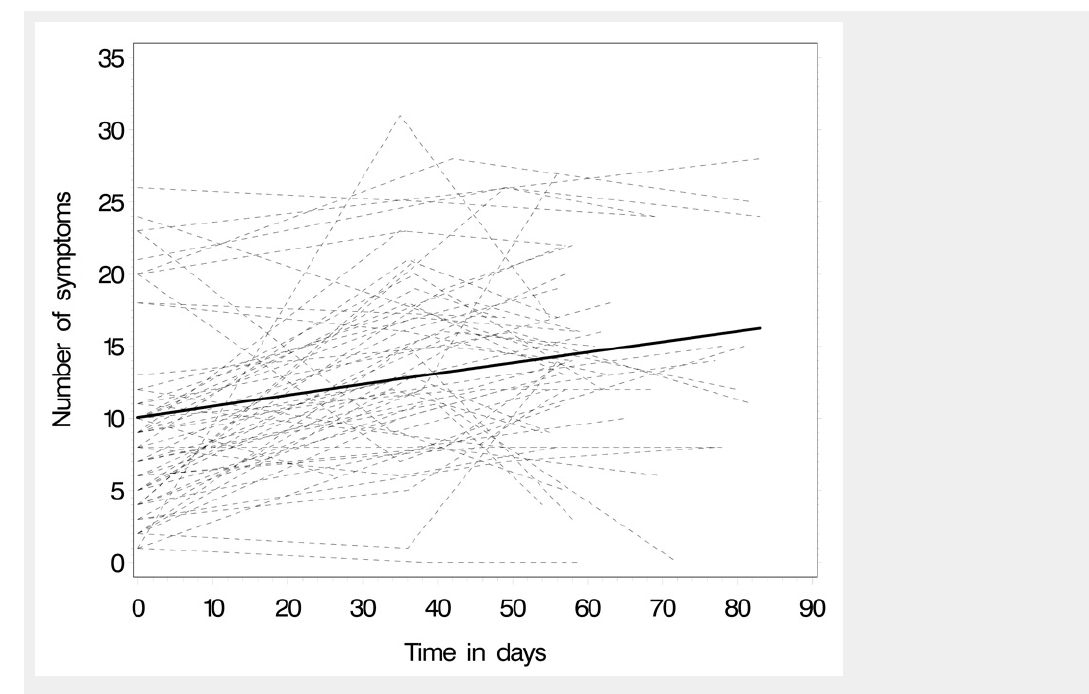
Figure 2 Predicted trend of number of symptoms over the three measurement points: thin lines represent patients’ individual trajectories, the thick line the average group trend.